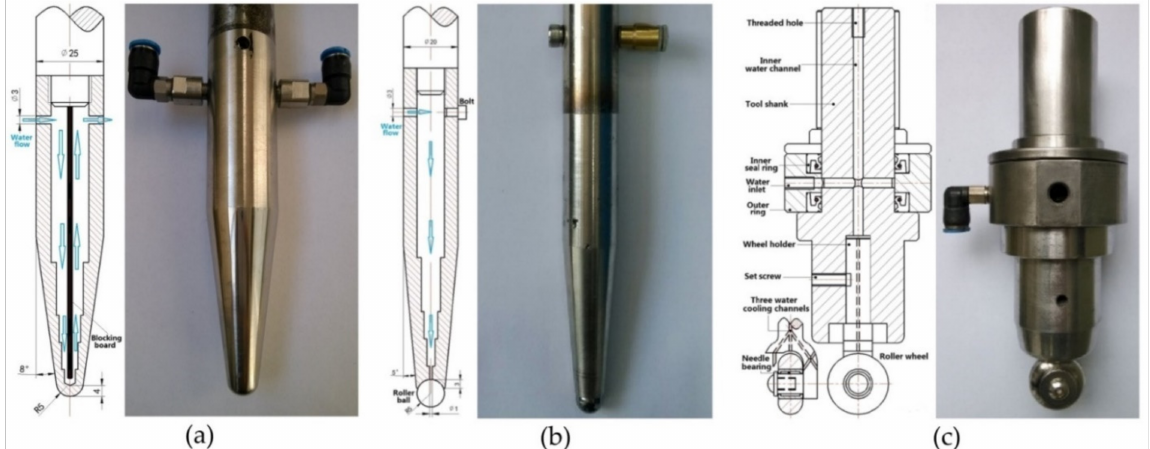
Figure 10. The tools that have been developed for use in E-ISF: ( a ) conventional rigid tool with inner water-cooling channel, ( b ) rolling-ball tool with inner water-cooling channel and ( c ) rolling-wheel tool with inner water-cooling channel (reprinted with permission from [101]; copyright © 2015, Springer-Verlag London).